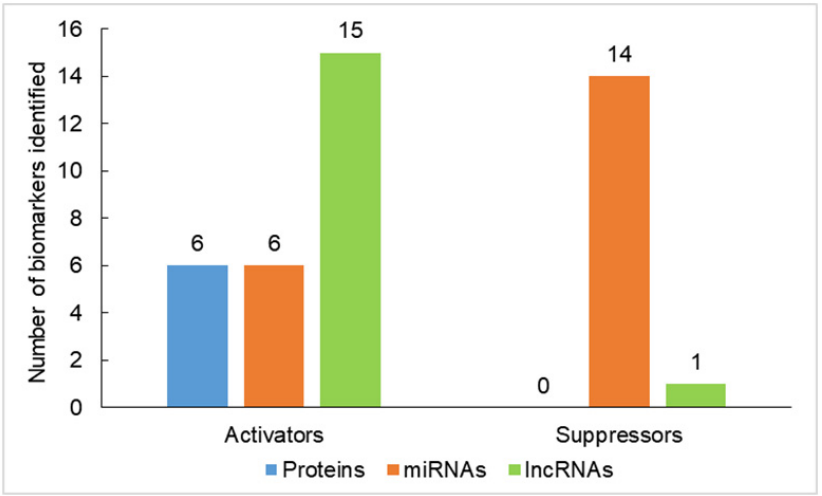
Figure 1. Histogram model showing the distribution of tumor activators and suppressors recently identified in epigenetic regulation of carcinogenesis for